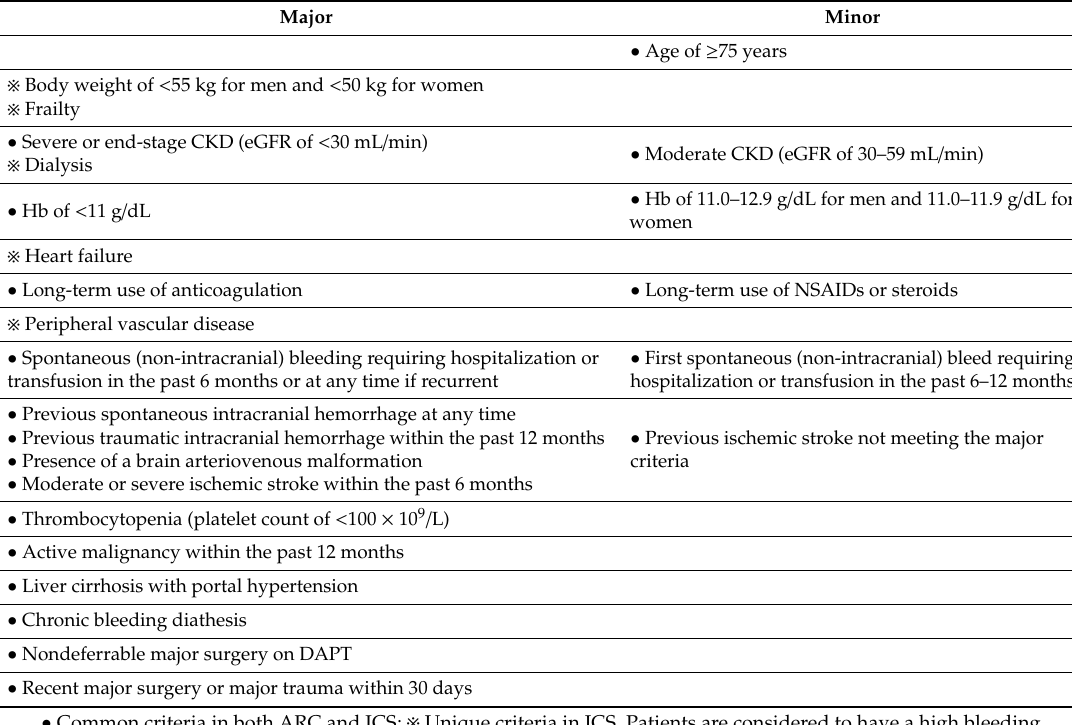
Table 1. Major and minor criteria for high bleeding risk defined by ARC and